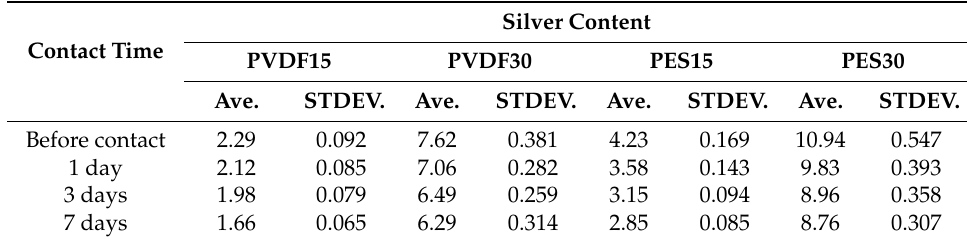
Table 3. Silver nanocomposite amount on modified and unmodified membranes surface measured by EDX.